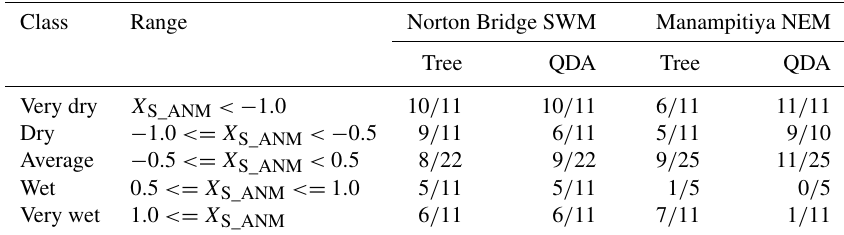
Table 5. Classification results for extreme dry (very low rainfall) and wet (very high rainfall) seasons. Class Range Norton Bridge SWM Manampitiya NEM Tree QDA Tree QDA Very dry X S_ANM < − 1 . 0 10 / 11 10 / 11 6 / 11 11 / 11 Dry − 1 . 0 < = X S_ANM < − 0 . 5 9 / 11